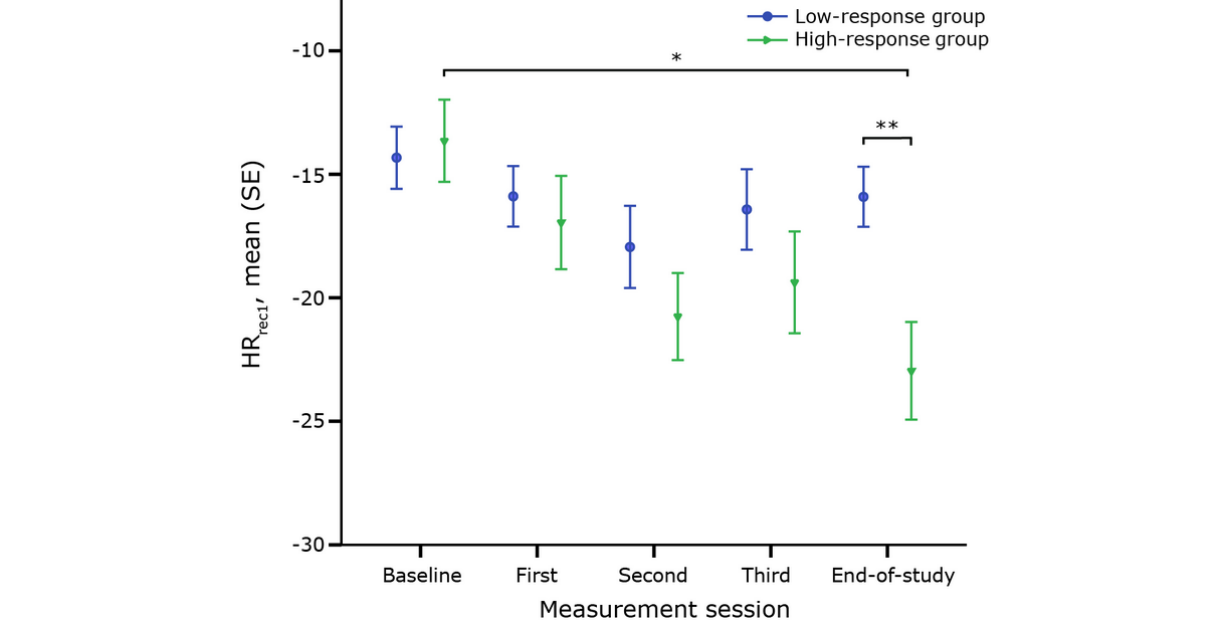
Figure 4. Heart rate recovery during the first minute (HR rec1 ) after the 6-minute walking test for each group throughout cardiac rehabilitation. *denotes a significant change over time; **denotes a significant difference in HR rec1 during a measurement session between both